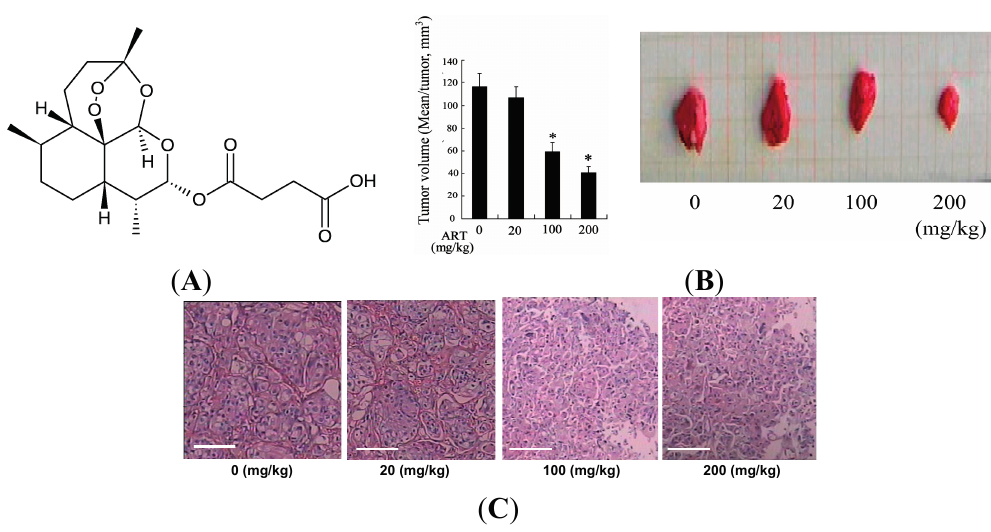
Figure 1. Chemical structure of Artesunate (ART) and ART inhibited tumor growth in the bladder cancer rat. Chemical structure of ART ( A ); Rats were given 0.05% of N -butyl- N -(4-hydroxybutyl) nitrosamine (BBN) in drinking water. Ten weeks later, the rats were treated with ART (0, 20, 100, 200 mg/kg) by subcutaneous injection. Ten rats were used for each treatment group. Ten weeks after treatment with ART, all rats were sacrificed and the tumor size was measured ( B ); Hematoxylin and Eosin (HE) stained cancer tissues showed ART treatment could reduce malignant lesions in a dose-dependent manner. Scale bar is equal to 20 μ m ( C ); * p < 0.05, indicate significant differences from those treated with 0 mg/kg